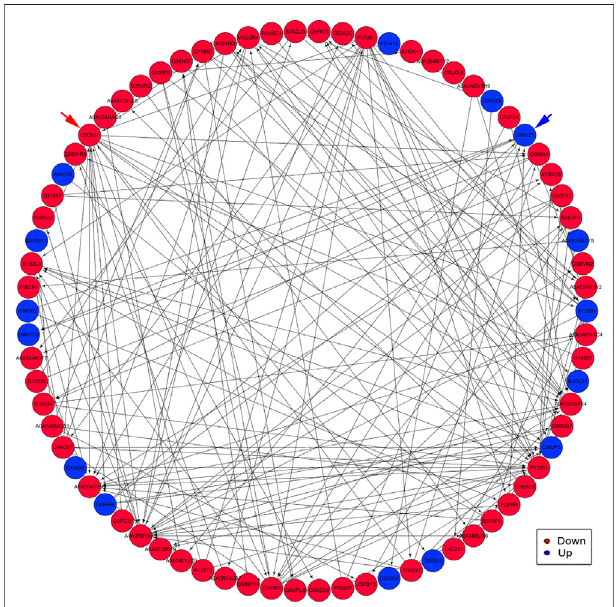
FIGURE8| AninteractionnetworkofPPIanalysis.Thenetworkrevealed the direct and potential regulatory relationships between DEP. The downregulated proteins are represented by red nodes. The upregulated proteins are represented by blue nodes. Blue arrow indicates the Q86V21 (AACS) protein. Red arrow indicates the Q00534 (cyclin-dependent kinase 6)